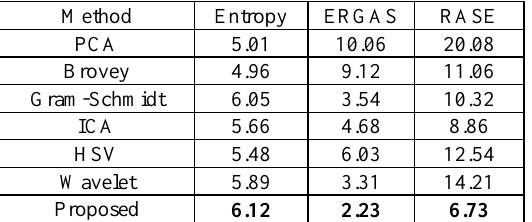
Table 1. Comparison of fusion methods